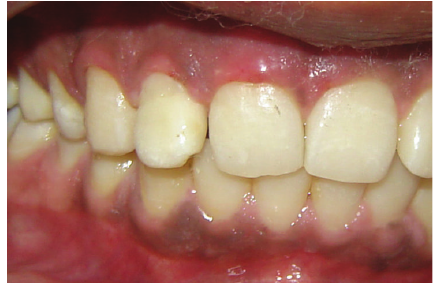
Figure 7: Labial view immediately after restoration of maxillary right lateral incisor.